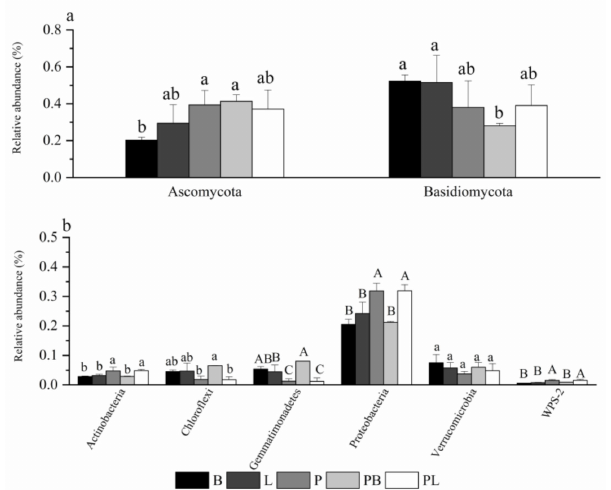
Figure 3. Relative abundance changes of fungi ( a ) and bacteria ( b ) sensitive species in five plantation types. Different lowercase letters represent significant differences, p < 0.05. Capital letters indicate extremely significant differences, p < 0.001. Details are described in Figure